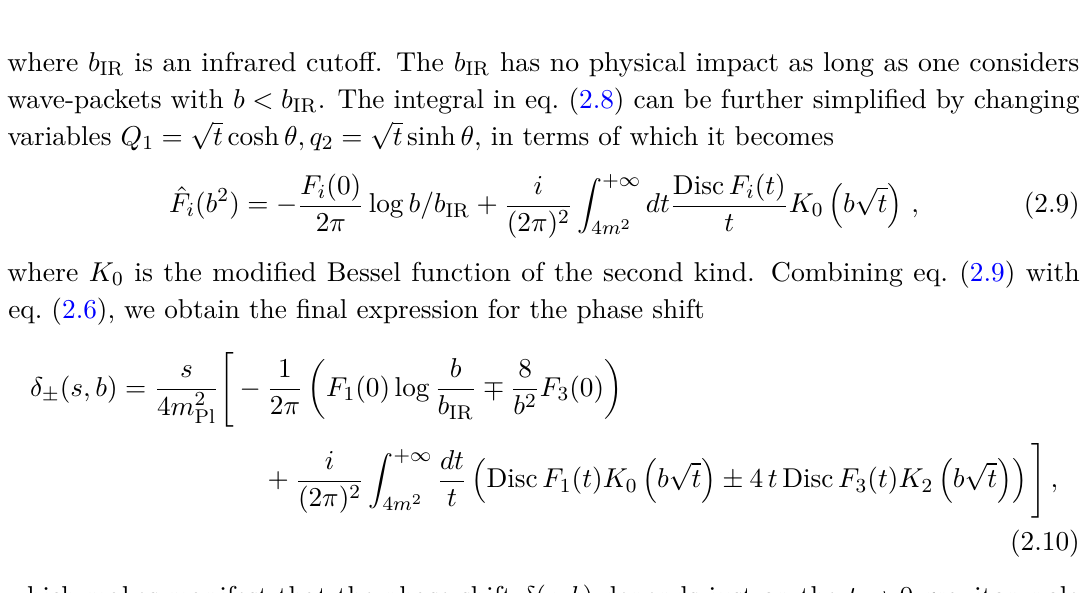
Figure 3 . Integral contour Γ in the upper complex q 1 -plane for ˆ F i . There are two contributions: one from the graviton pole, and the second from the discontinuity above threshold t > 4 m 2